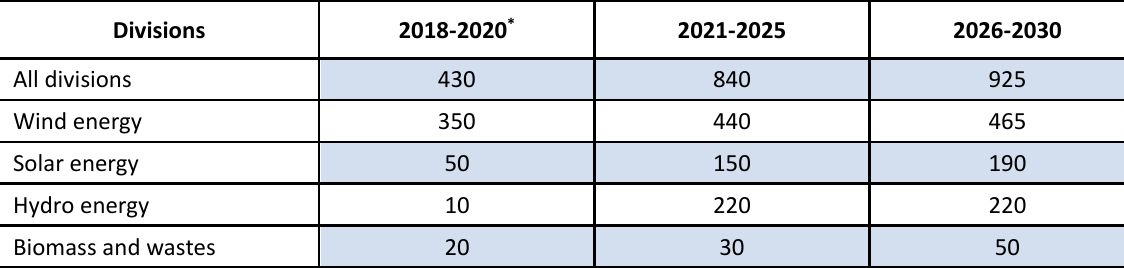
Table 4 Renewable electricity production in Azerbaijan by 2030